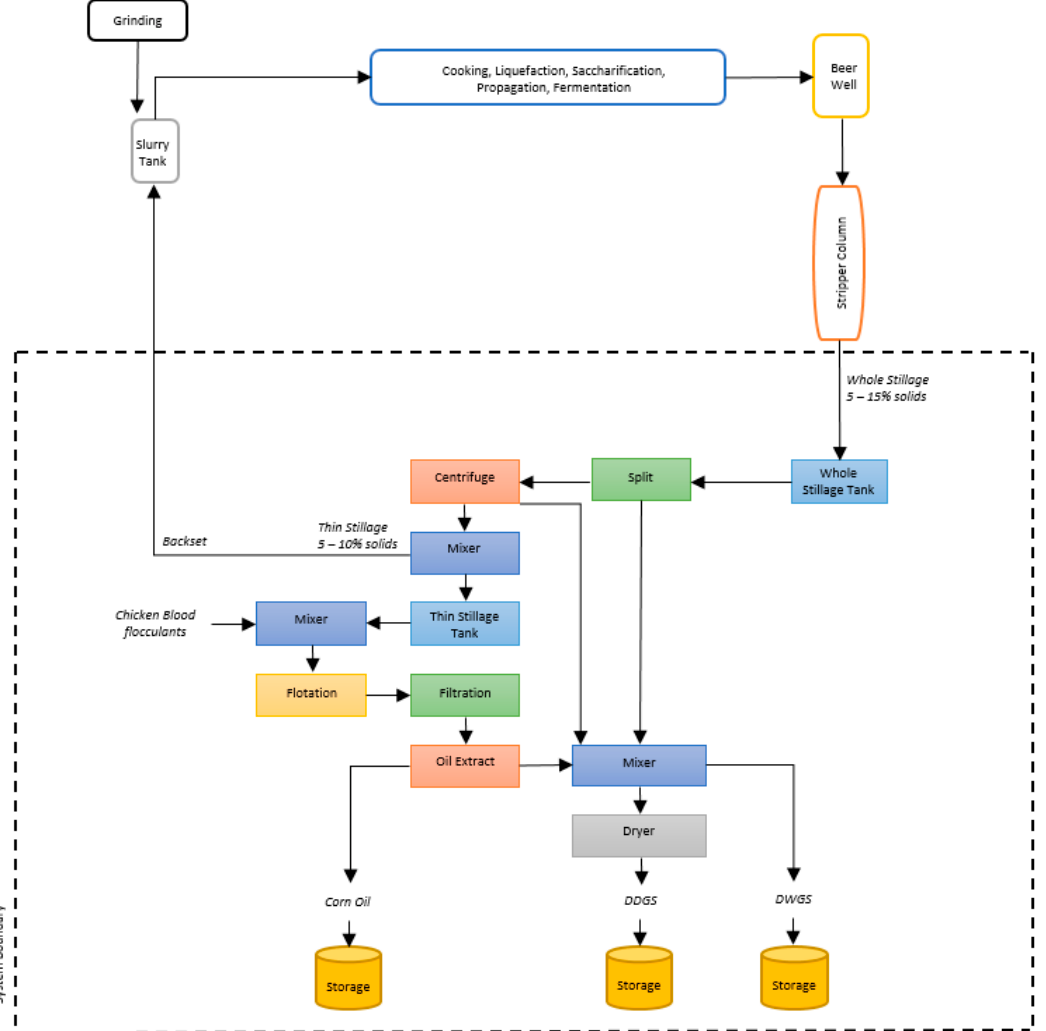
Figure 2. Simplified flow diagram of a corn-based ethanol plant with flocculation process (Scenario II). The system boundary includes tanks, splitter, centrifuge, mixers, dryer, flotation, filter, and storage